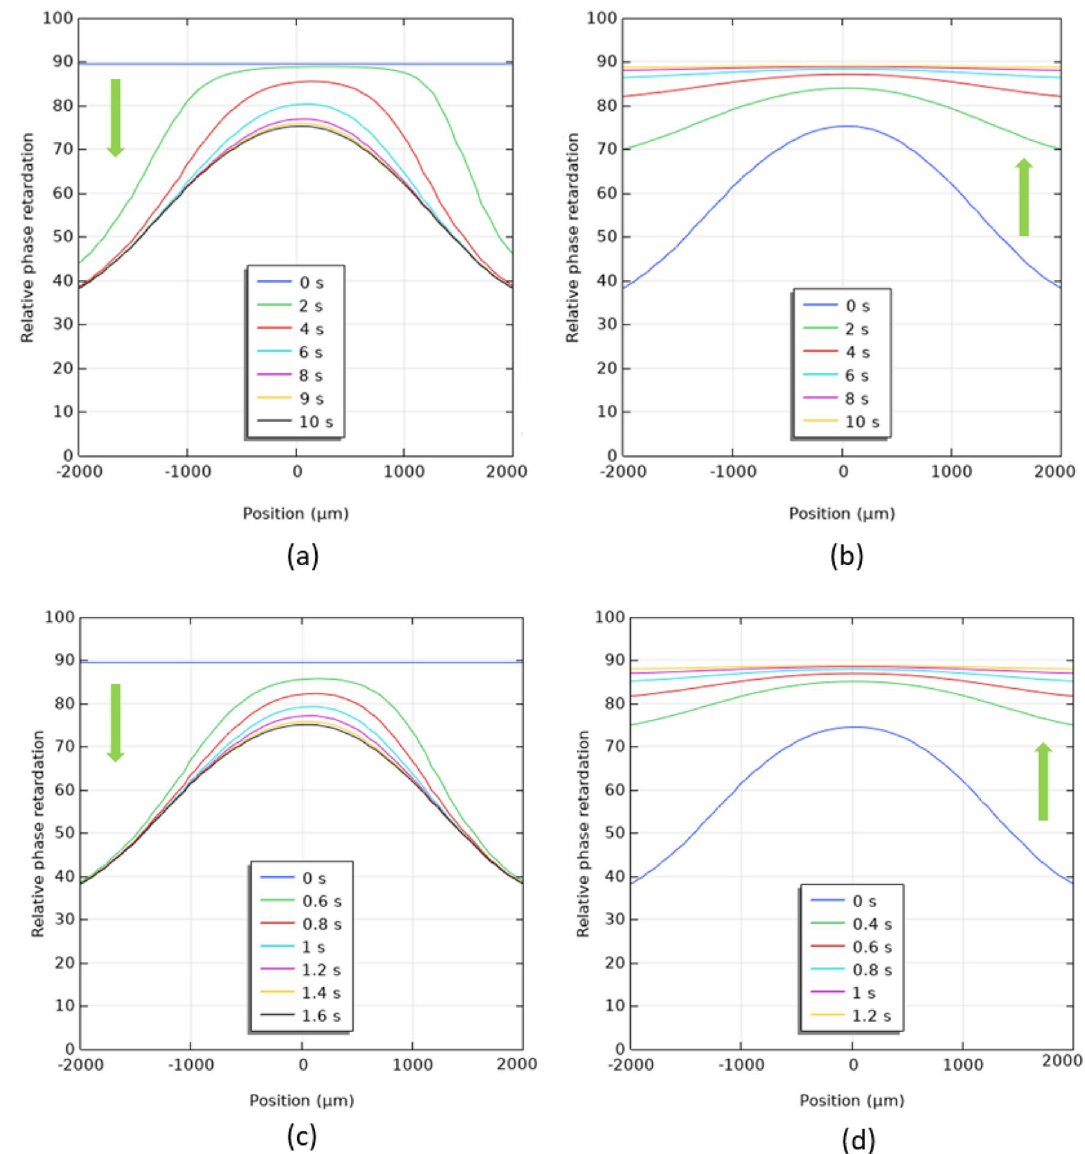
Figure 6. Calculated time-dependent phase (wavefront) conversions in ( a ) voltage turn-on and ( b ) voltage turn-off processes for γ 235 -HLC lens; calculated time-dependent phase (wavefront) conversions in ( c ) voltage turn-on and ( d ) voltage turn-off processes for γ 45 -HLC lens.